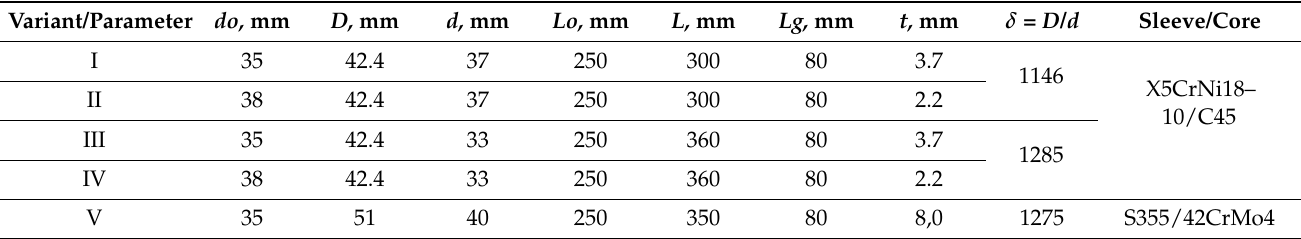
Table 1. Geometric parameters of billets and rolled bimetallic